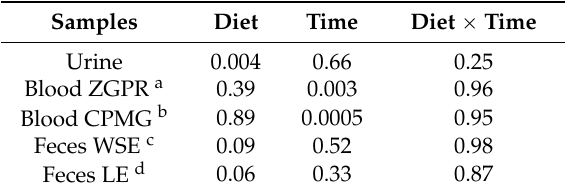
Table 2. p values of ASCA models by 10,000 permutations